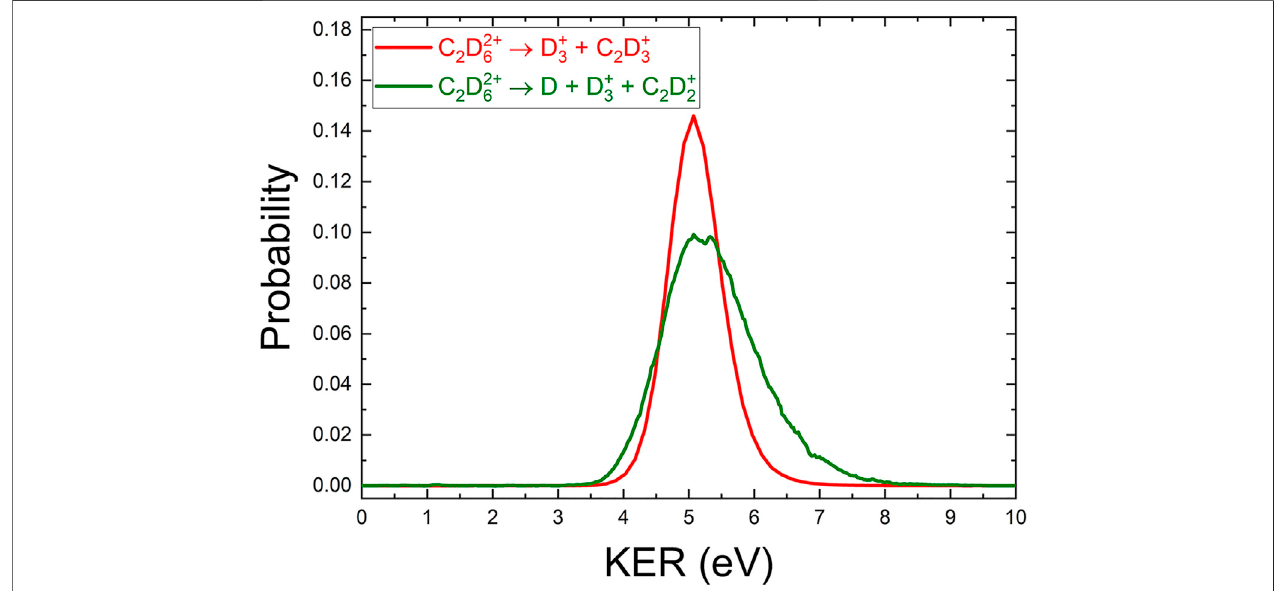
FIGURE 6 | A comparison of the (COLTRIMS-derived) KER spectrum of D + 3 + C 2 D + 3 (red) and D + D + 3 + C 2 D + 2 (olive) produced by 25 fs, 1.5 × 10 14 W/cm 2 laser pulses centered at 790 nm.